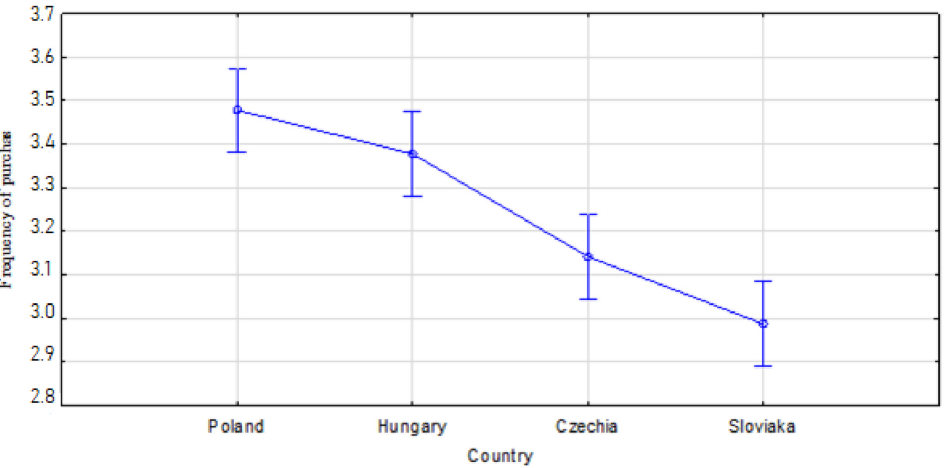
Figure 1. The frequency of purchasing organic food on a 1–5 point scale; where 1—very rarely, 5—very often; F (3.295) = 20.556; p <